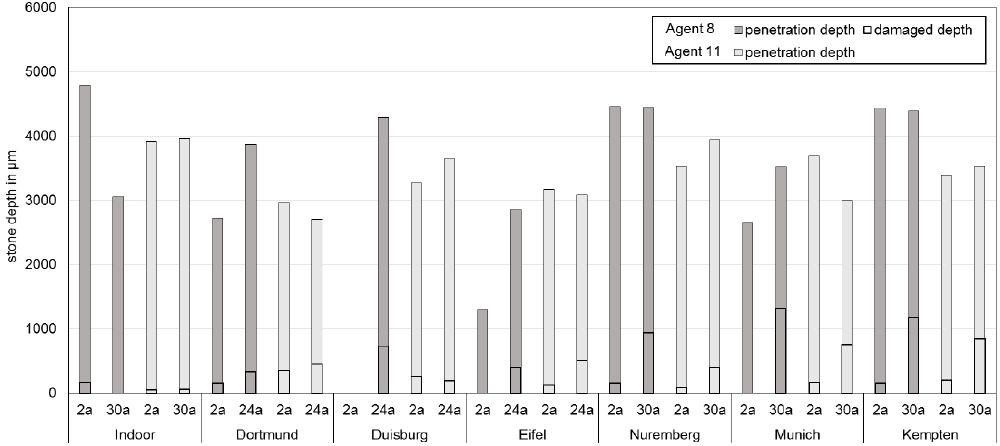
Figure 15. Comparison of the penetration depth of agents 8 and 11 applied on OKS with the damaged depth calculated with Equation (5) (depth 0 = surface of the stone).